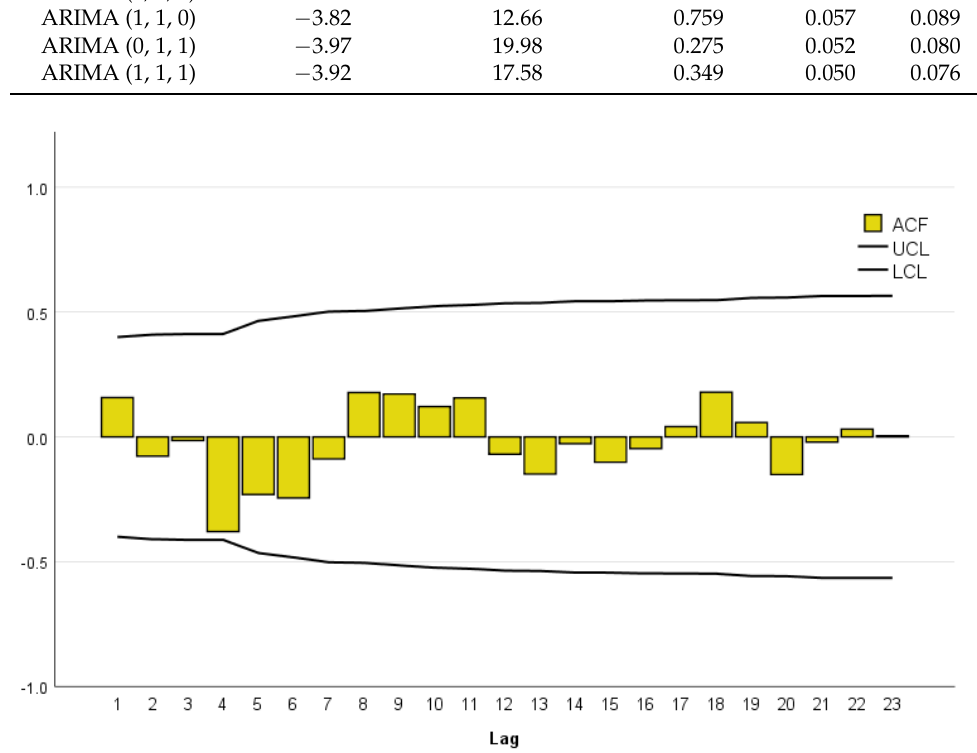
Figure 2. Residual ACF of the ARIMA model (0, 0, 1).